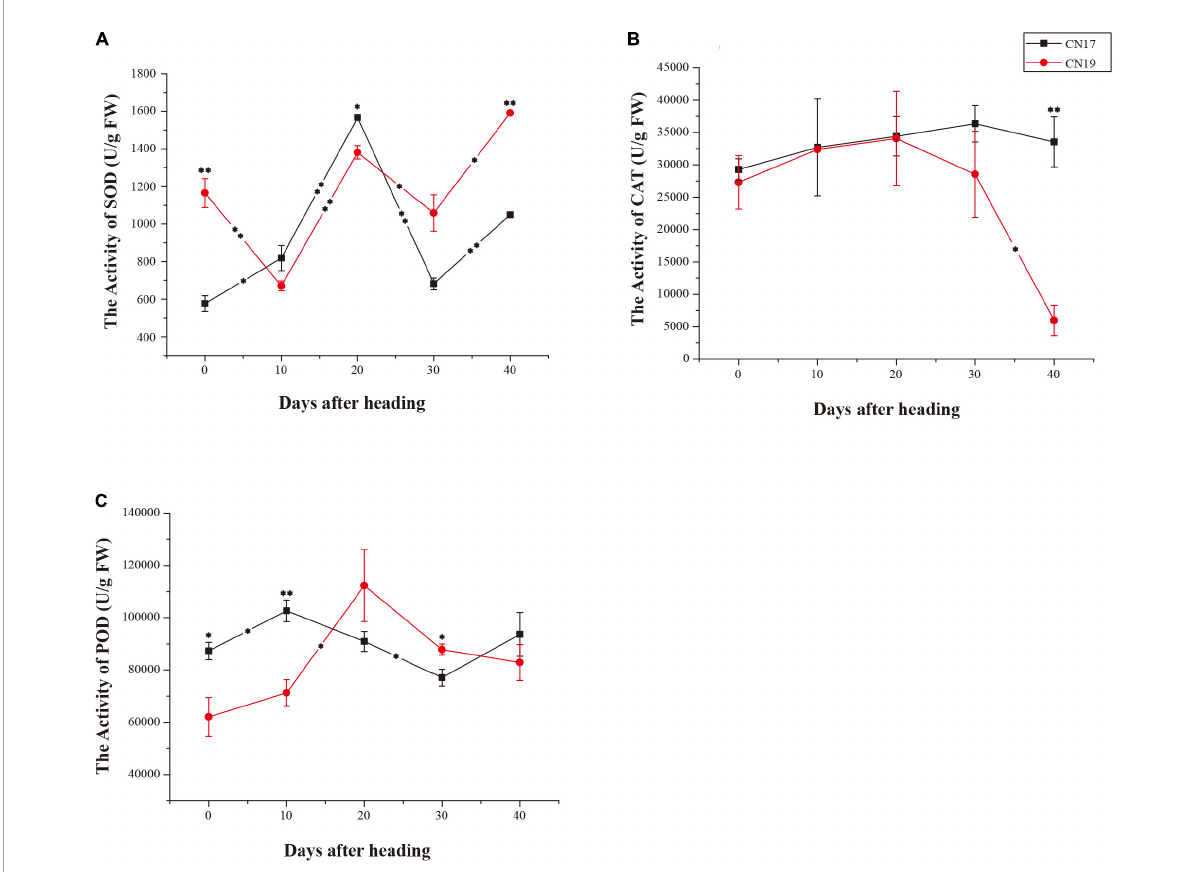
FIGURE3 Differences in antioxidant enzyme activity in stay-green cultivar CN17 and non-stay-green cultivar CN19 after heading. (A) Superoxide dismutase (SOD); (B) Catalase (CAT); (C) Peroxidase (POD). The bars indicate the mean ± standard error ( n = 3). ∗ and ∗∗ for significant differences at P ≤ 0.05 and P ≤ 0.01, respectively; the asterisks within the lines for significant differences between adjacent time points for the same wheat cultivar; the raised asterisks for significant differences between genotypes at each time point.